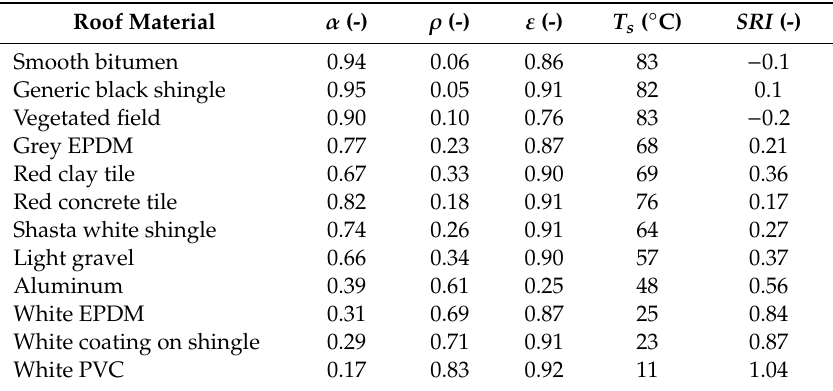
Table 4. Solar performance of roofing materials